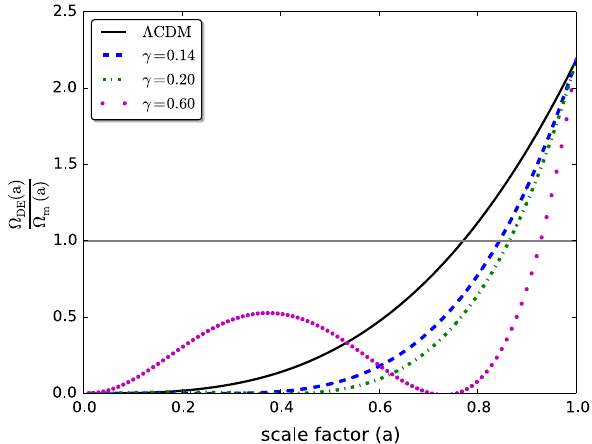
Fig. 2 Ratio of Ω DE ( a ) to Ω m ( a ) as a function of scale factor. The other free parameters have been fixed by SNIa observational constraint. The Λ CDM best fit is given by Planck observation